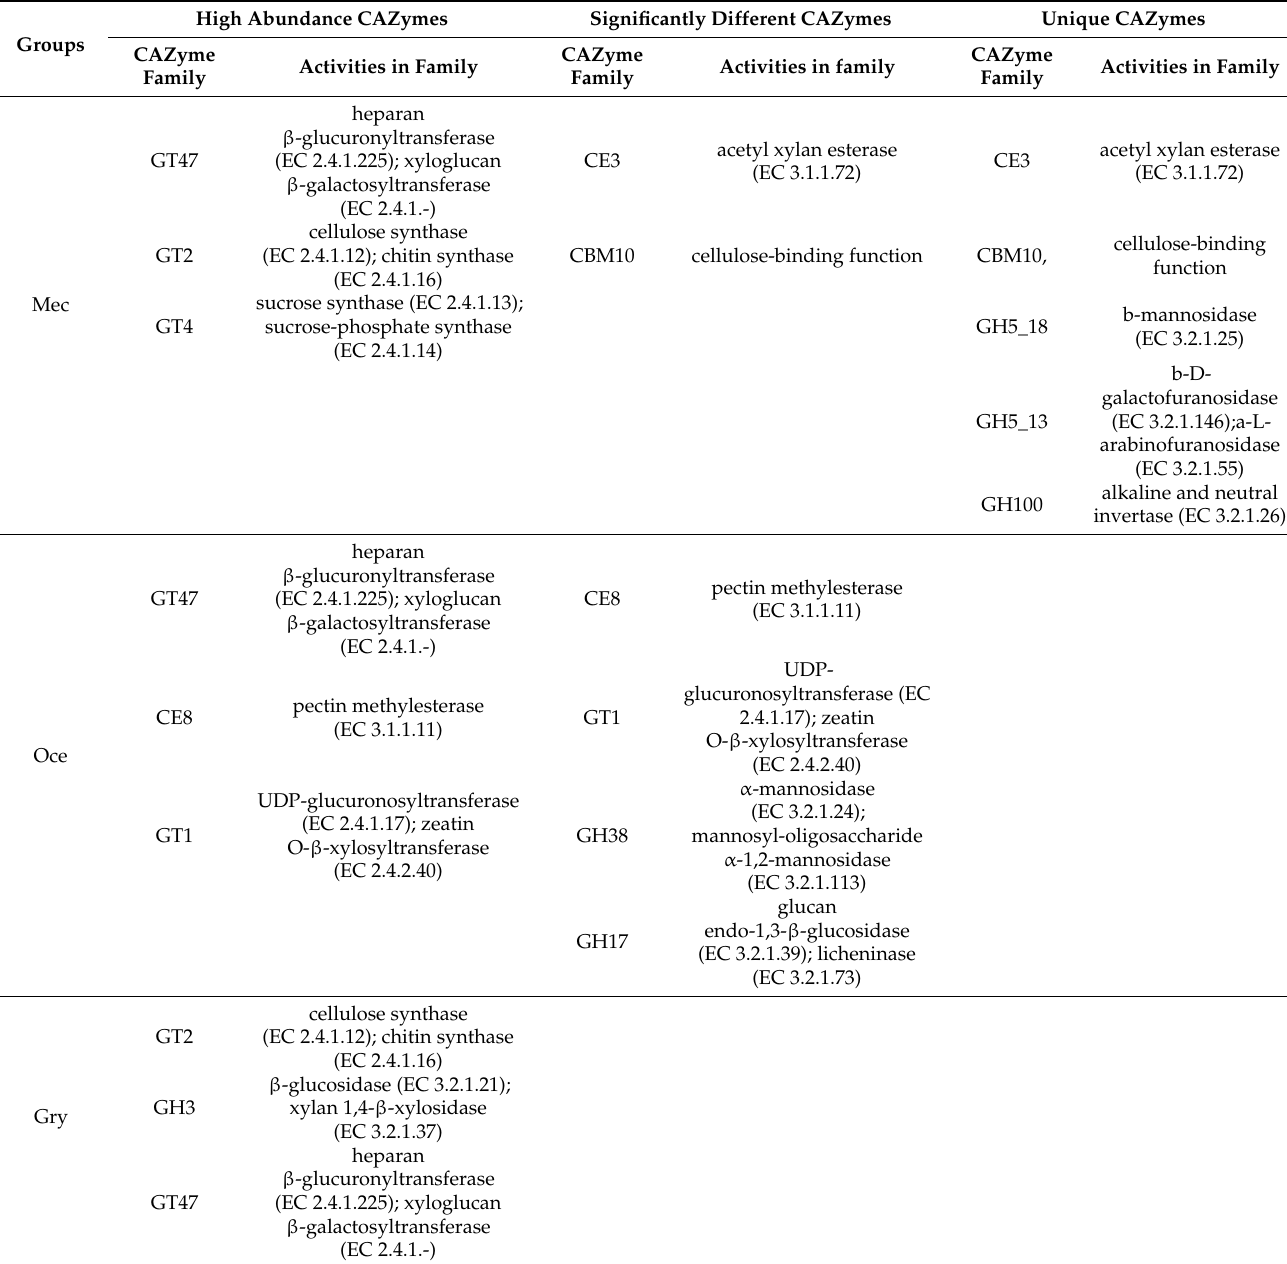
Table 4. Comparison of CAZyme families in the three